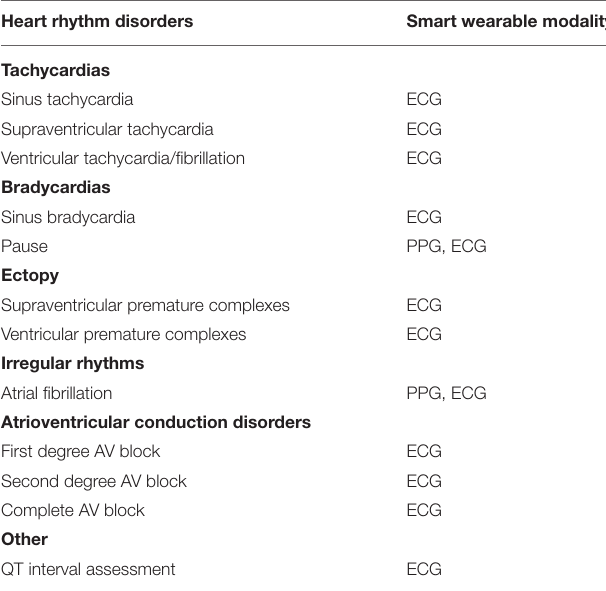
TABLE 4 | Heart rhythm disorders identified by wearable devices and the respective modality used to detect them. Heart rhythm